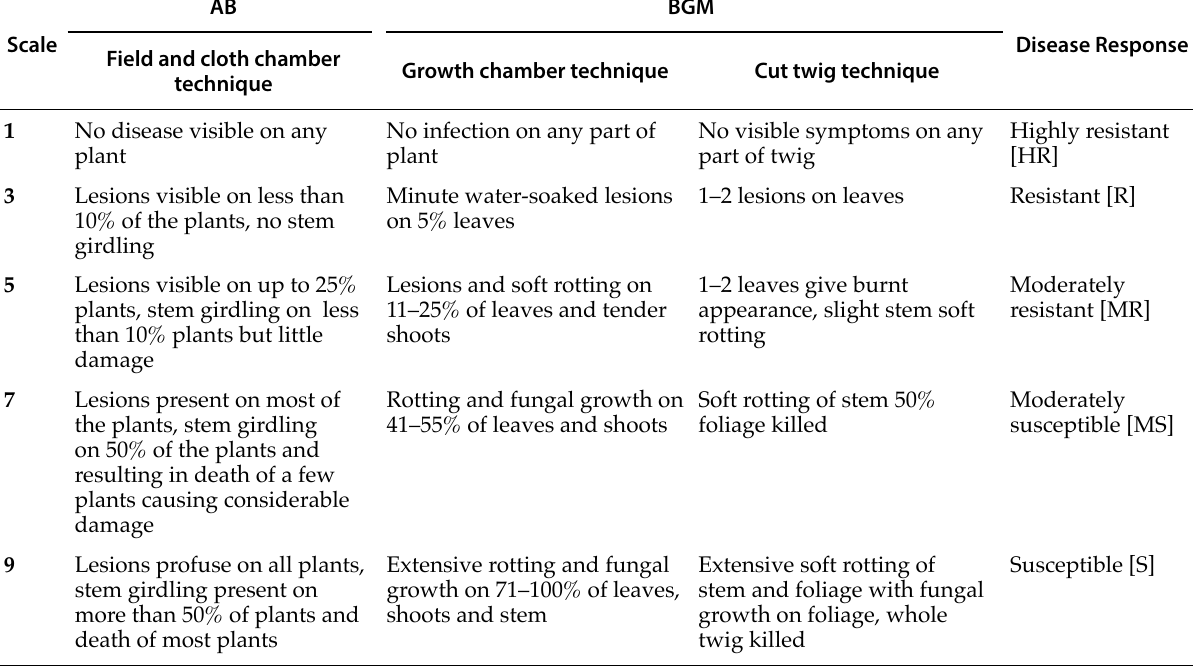
Table 1. Disease rating scale for Ascochyta blight (AB) and Botrytis grey mould (BGM) in chickpea using different screen - ing